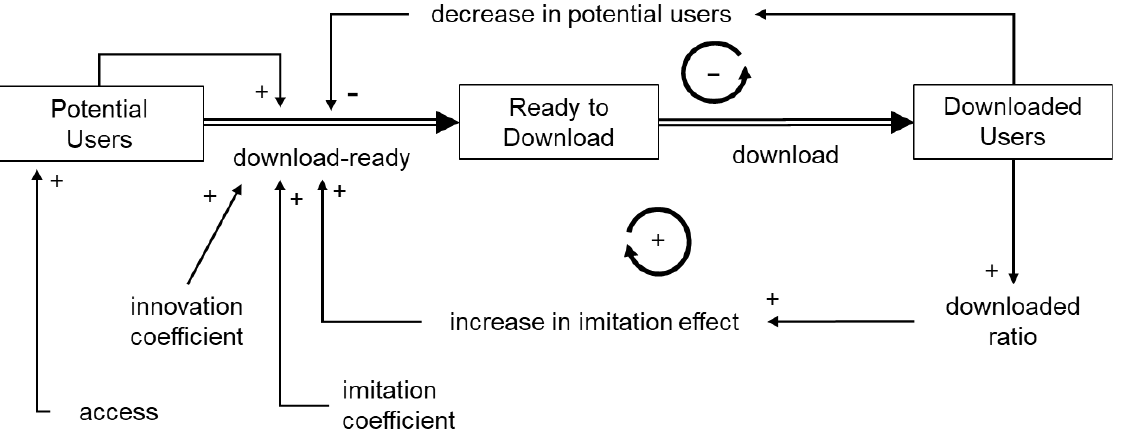
Figure 2. A conceptual system dynamics model of app downloads based on Bass’ new product growth model.